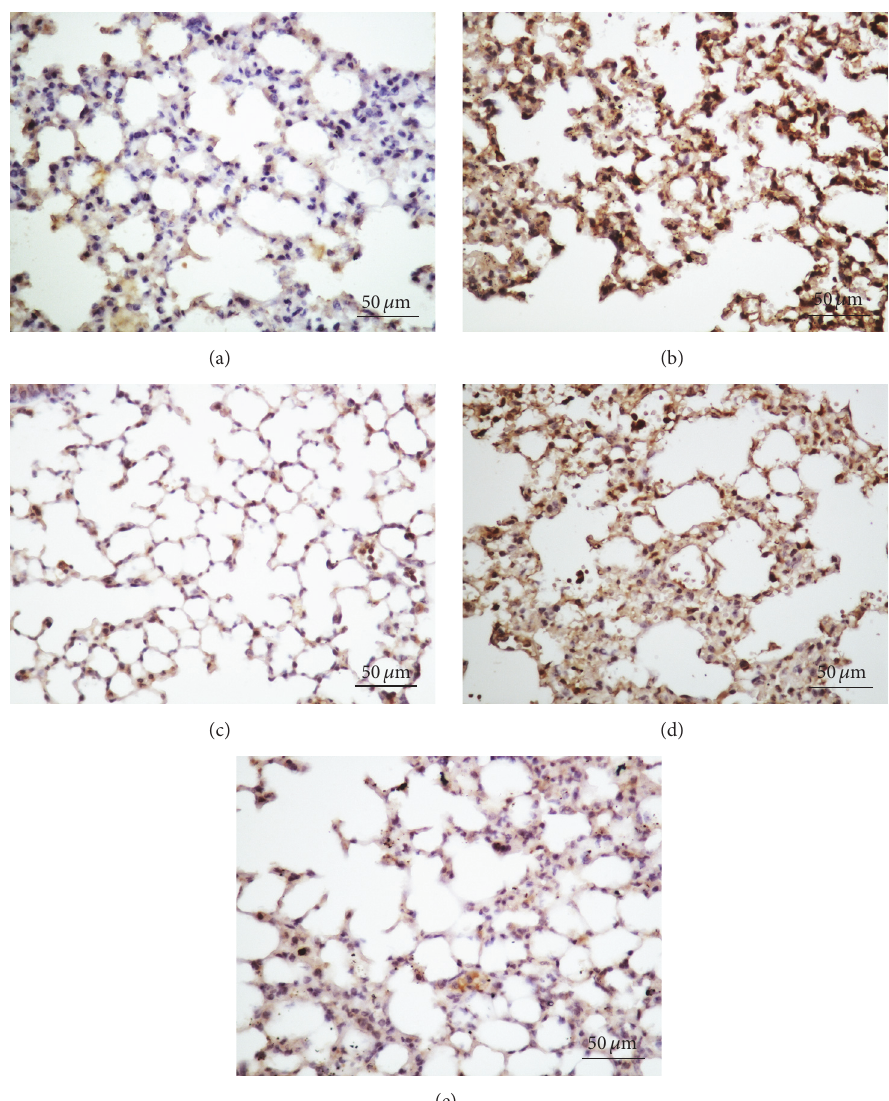
Figure 2: Representative immunohistochemical analysis of NF- 𝜅 B from (a) the control group, (b) the LPS-treated model group, (c) mice treated with DEX (2mg/kg), and (d and e) mice treated with V. axillare (400 or 1200mg/kg). Magnification: 200x, scale bar: 50 𝜇 m.